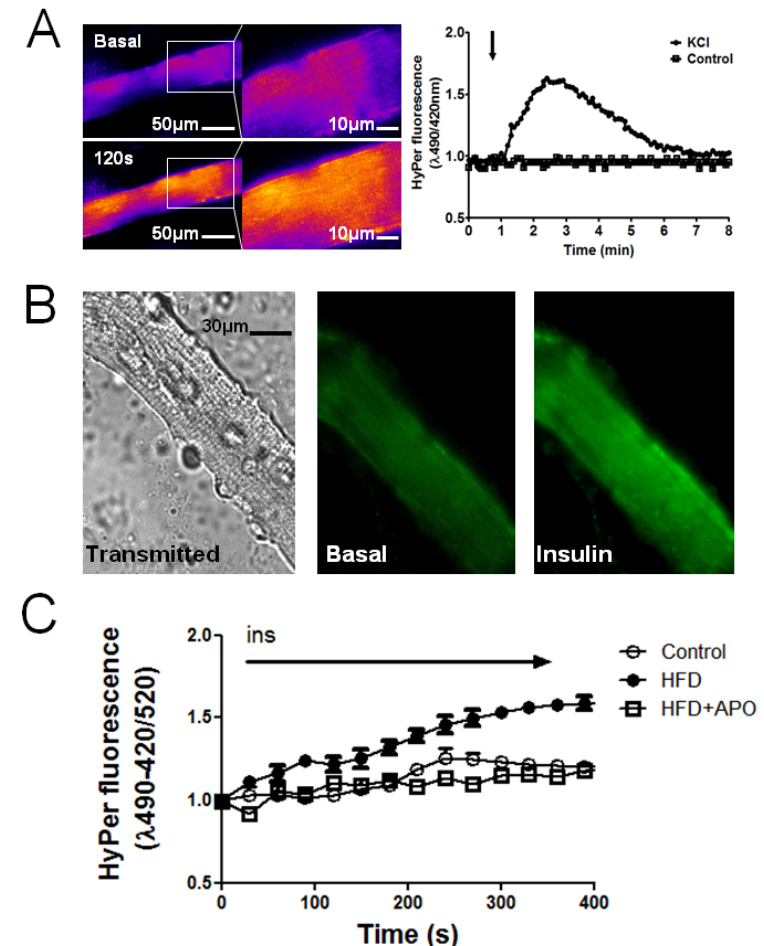
Figure 2. High-fat diet (HFD) effects on H O production. ( A ) H O generation was 2 2 2 2 measured before and after 45 mM K + addition. Left panel shows fluorescence in pseudo-color in basal and 120 s after depolarization. Right panel shows the kinetics of depolarization-induced H O ; ( B ) Transmitted light and HyPer fluorescence image of a 2 2 single fiber; ( C ) Time course of changes in the fluorescence ratio of HyPer-Cyto upon addition of 100 nM insulin ( → ) to muscle fibers of control and high-fat diet mice (HFD) and mice pre-incubated with apocynin (15 min) (50 µM APO) (mean ± SEM). Radiometric changes are shown; images were acquired using an excitation/emission wavelength λ −λ / λ = 420 − 490/520 nm. We normalized the ratio of basal fluorescence in exc1 exc2 em muscles from animals under different